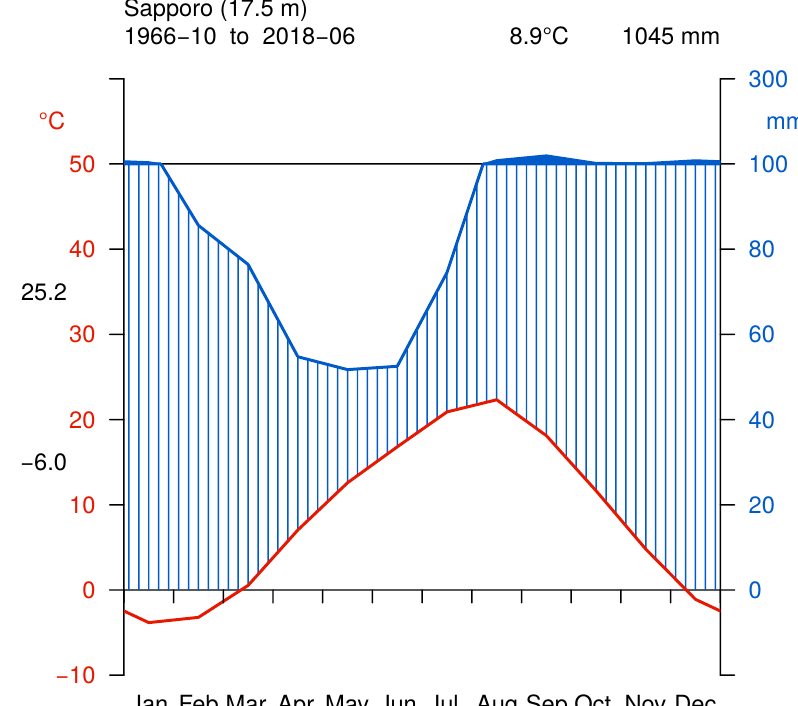
Figure 1. Walter and Lieth climate diagram exhibiting monthly averages for air temperature (left y -axis, red colored) and average sum of monthly precipitation (right y -axis, blue colored) in the period from October 1966 to June 2018 for Sapporo. Humid conditions are characterized by blue lines above the red curve. The black values on the left hand side ( y -axis) reveal the maximum and minimum air temperatures. The annual average air temperature and annual sum of precipitation can be found in the upper right corner